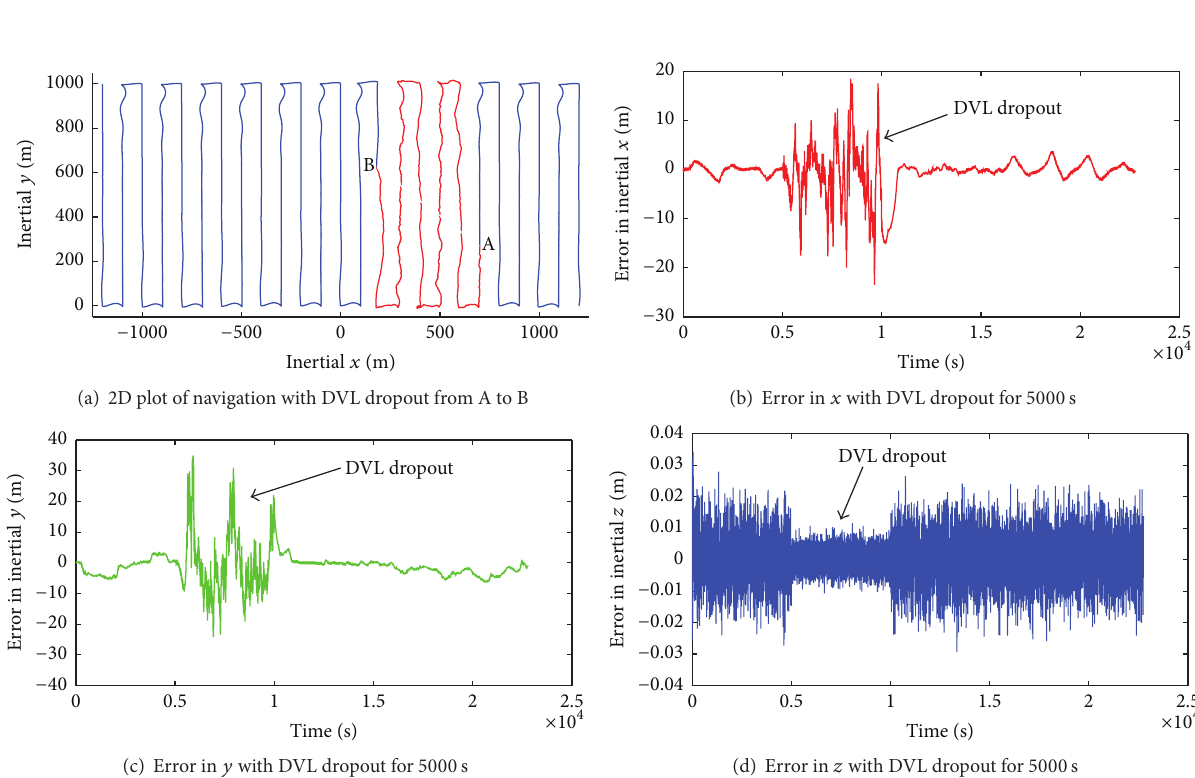
Figure 5: Navigation with DVL dropout for 5000